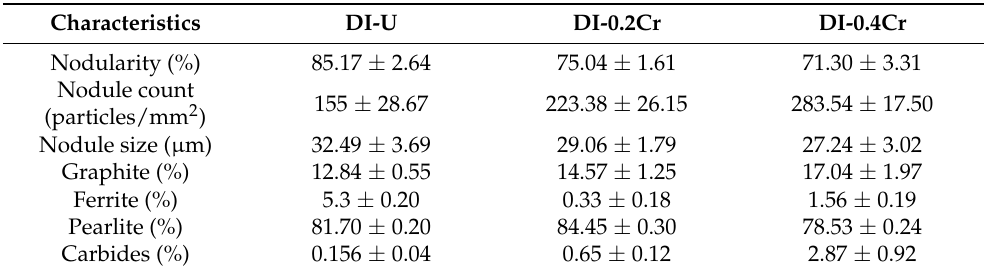
Table 2. Graphite features and volume fraction of phases formed for camshafts unalloyed and alloyed with 0.2 and 0.4%